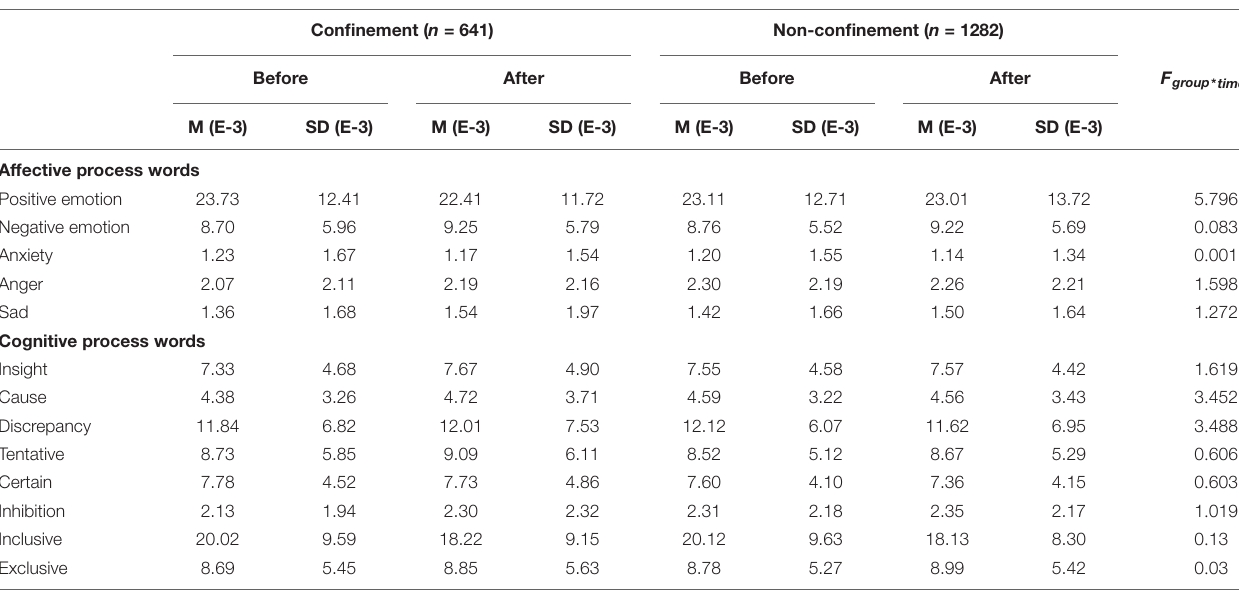
TABLE 6 | The results of RM ANOVA in low-endemic